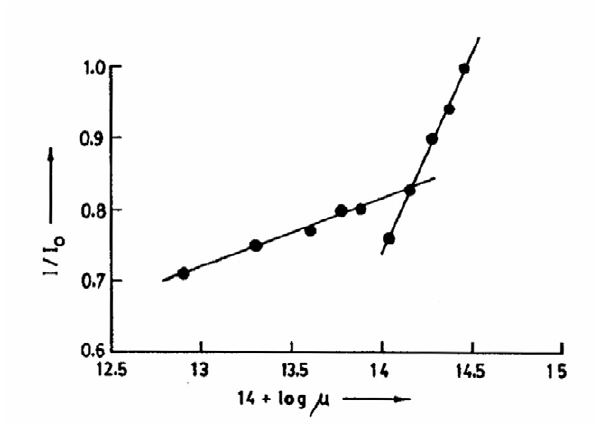
Figure 8. Plot of I/I